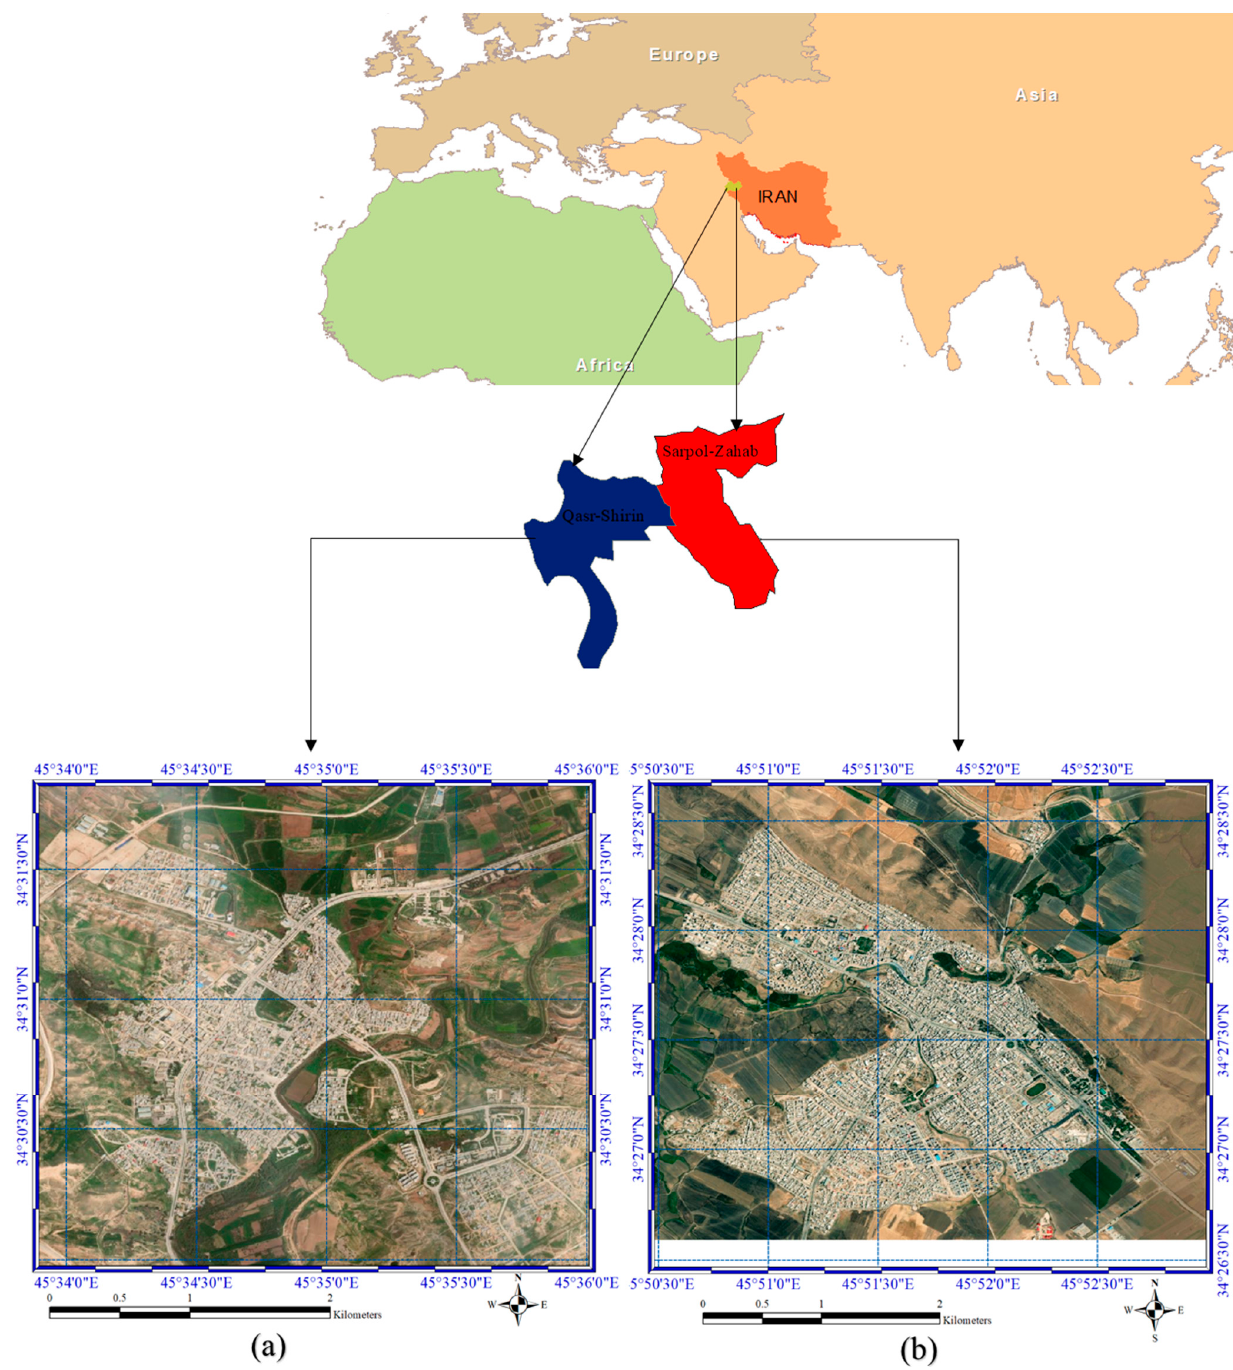
Figure 2. The case study areas from Sentinel-2 data that acquired on the 5th of 2017, ( a ) Qasr-Shirin, and ( b ) Sarpol-Zahab.